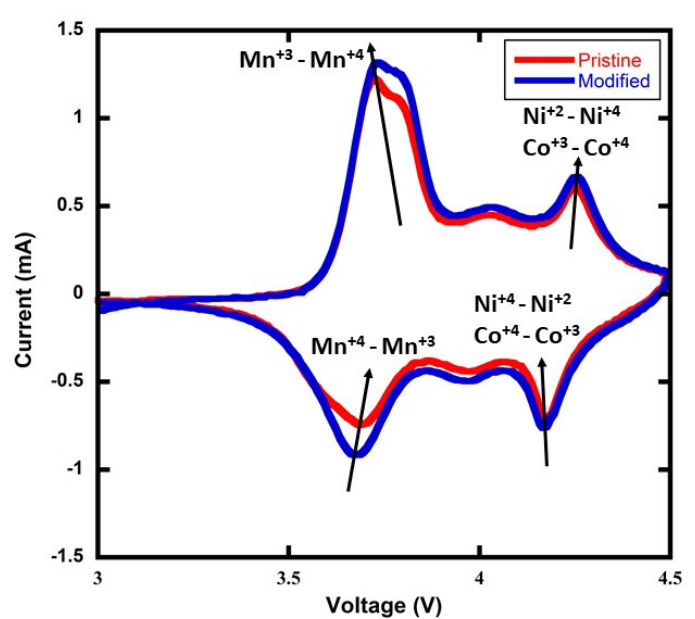
Figure 3. Cyclic voltammetry (CV) measurement for rGO/NMC811 (denoted in the plot legend as modified) with 5wt% rGO additive. The control data are denoted as pristine in the plot legend and show the battery performance with no rGO added. The scan rate is 0.1 mV s − 1